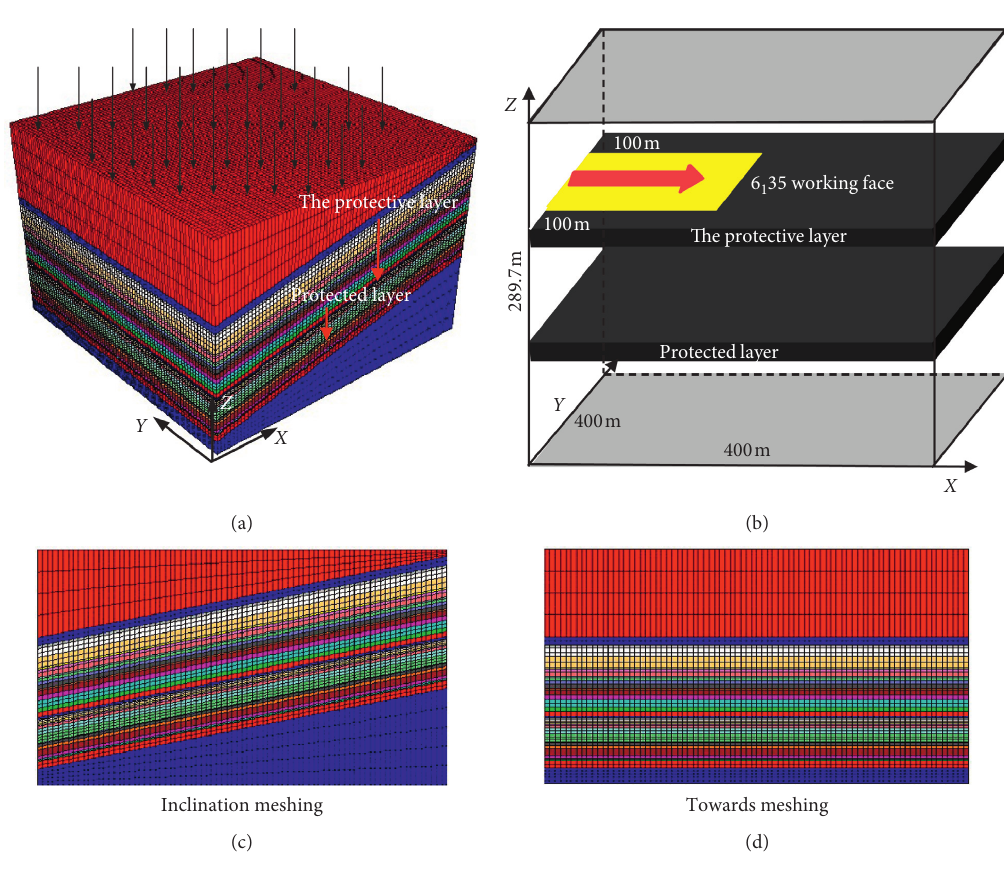
Figure 2: Longwall panel 6